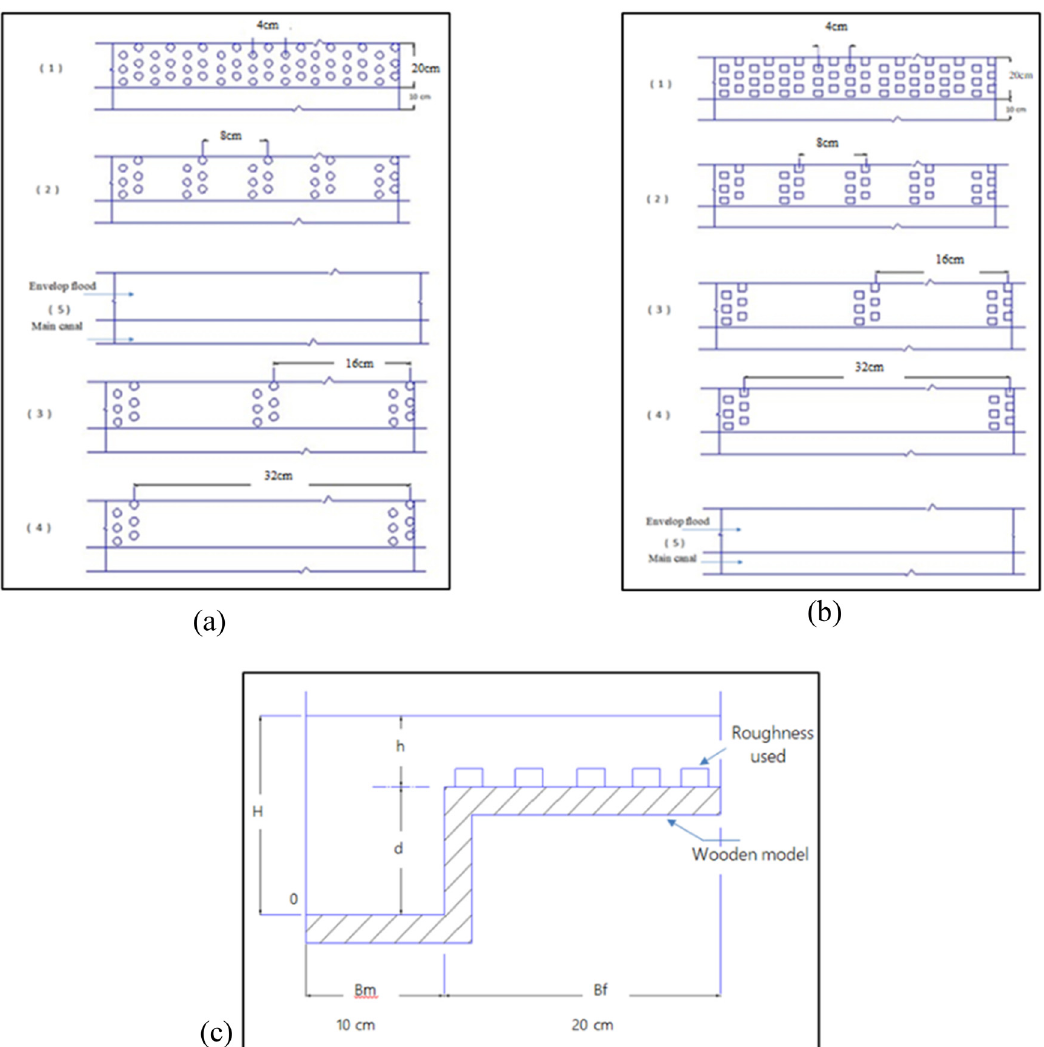
Figure 2: Laboratory fl ume roughness distribution, ( a ) using cylindrical pieces and ( b ) using cubic parts, and ( c ) channel cross - section clarifying roughness distribution in a fl ood